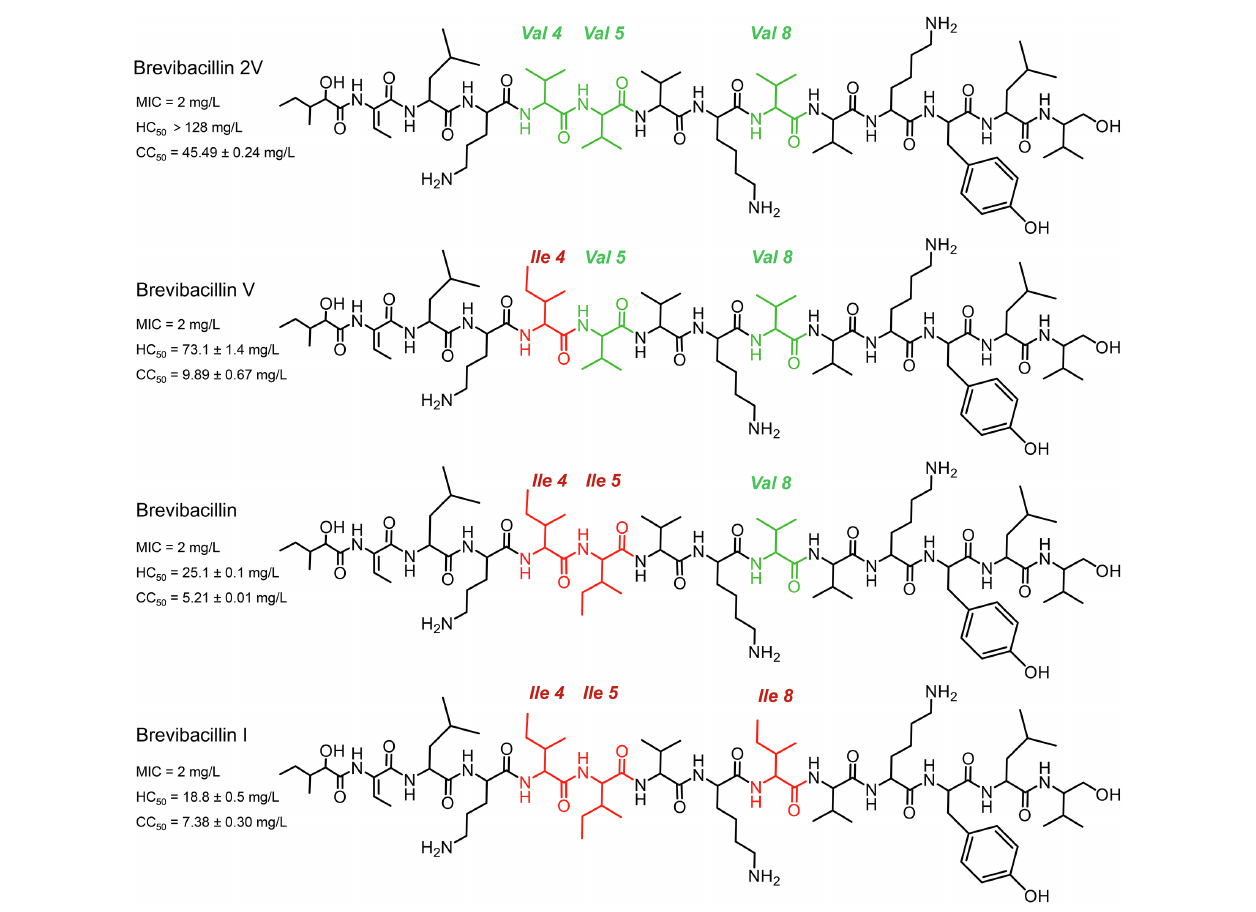
FIGURE 1 | Structures of brevibacillins. The red color indicates the more hydrophobic amino acid residues of brevibacillin V, brevibacillin and brevibacillin I relative to brevibacillin 2V. MIC, the minimum inhibitory concentration against Staphylococcus aureus (MRSA). HC 50 , the 50% human blood cell hemolysis concentration. CC 50 , the 50% cell (HepG2) toxicity